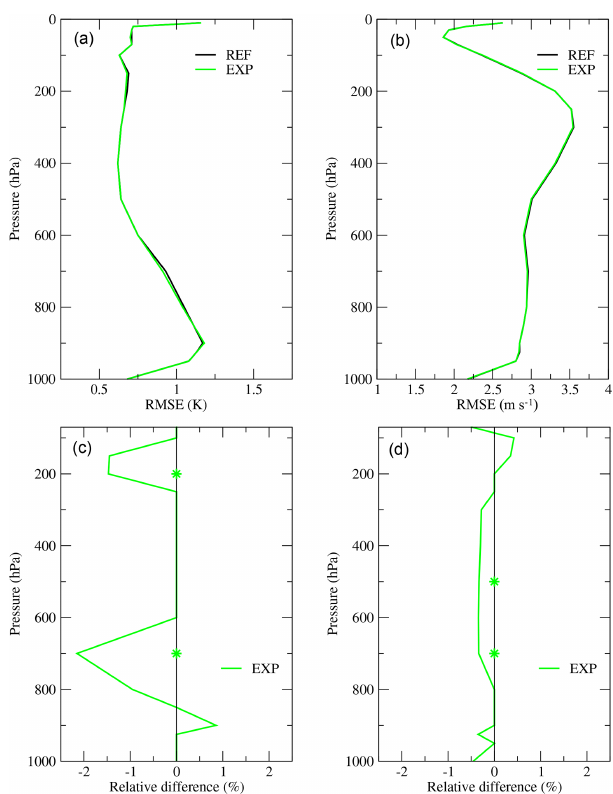
Figure 9. Root-mean-square error of the 12h forecast error for the Southern Hemisphere computed with respect to ECMWF analyses over the period from 7 December 2017 to 17 January 2018 for REF (in black) and EXP (in green) for temperature (a, c) and wind (b, d) . The second line represents the relative difference with respect to the reference. Green stars indicate that the differences of EXP with REF are statistically significant according to a bootstrap test with a 99.5% confidence